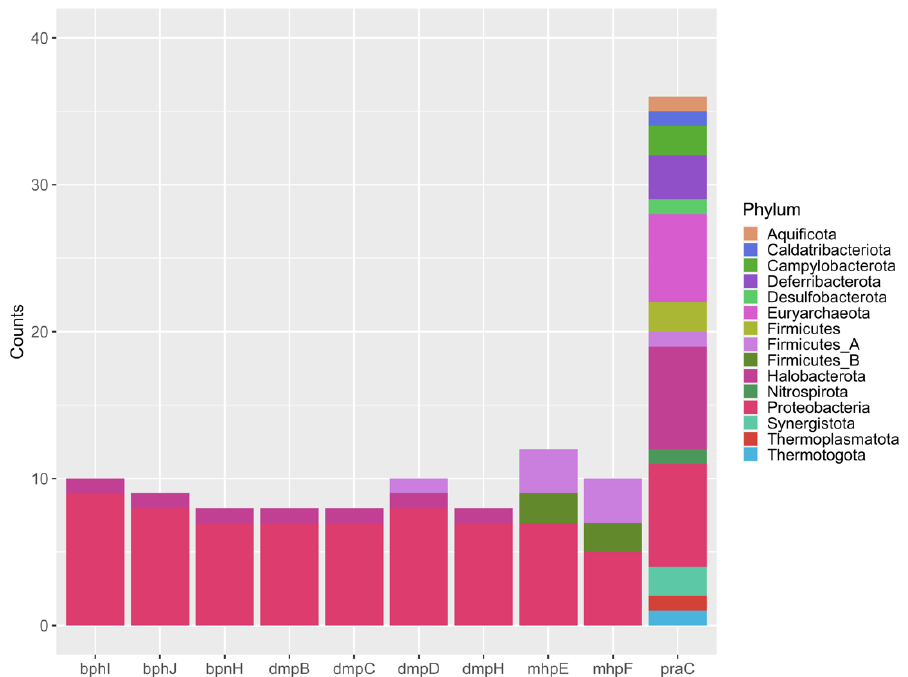
Figure 5. Frequencies of the genes from the Catechol meta-cleavage module across the phyla detected in oils reservoirs under study. Colors represent the phylum annotation.